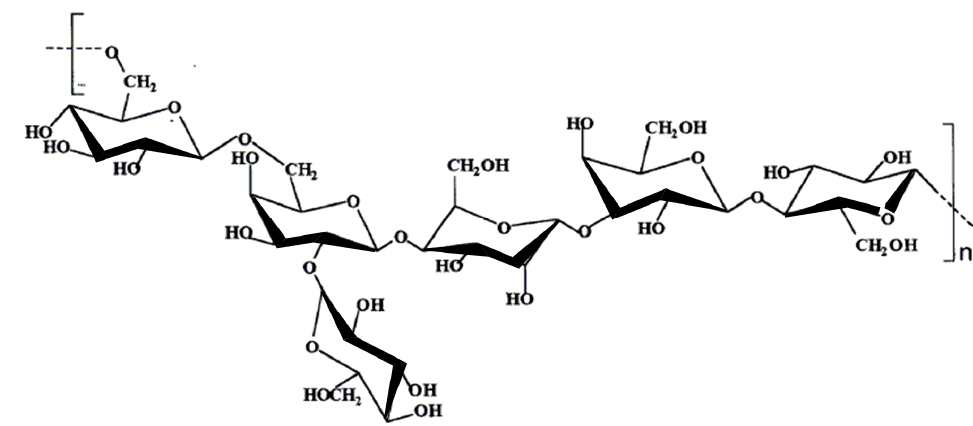
Figure 2. The structure of kefiran, the polysaccharide found in kefir grains [75].